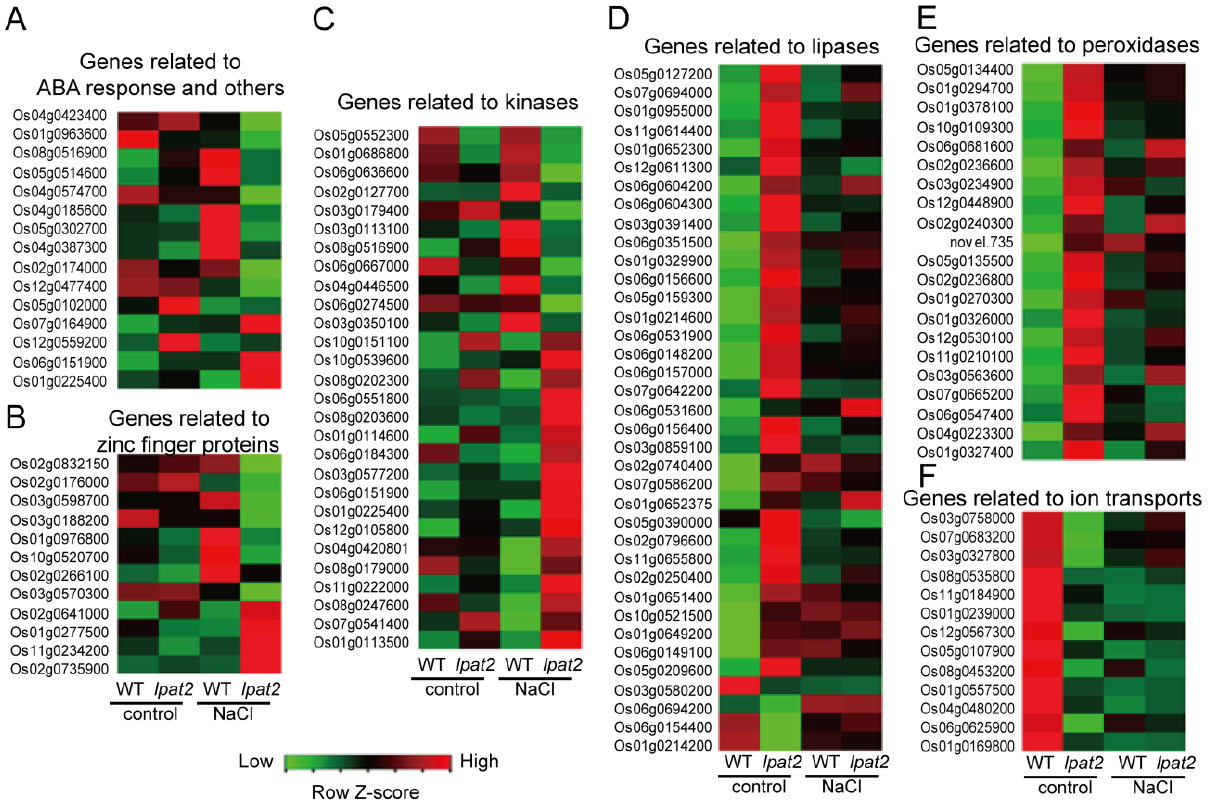
Figure 9. The heat map of selected differentially expressed genes involved in osmotic stress re- sponse. Heat map were generated by using the average values of FPKM. Green color shows the downregulation and red shows the upregulation.